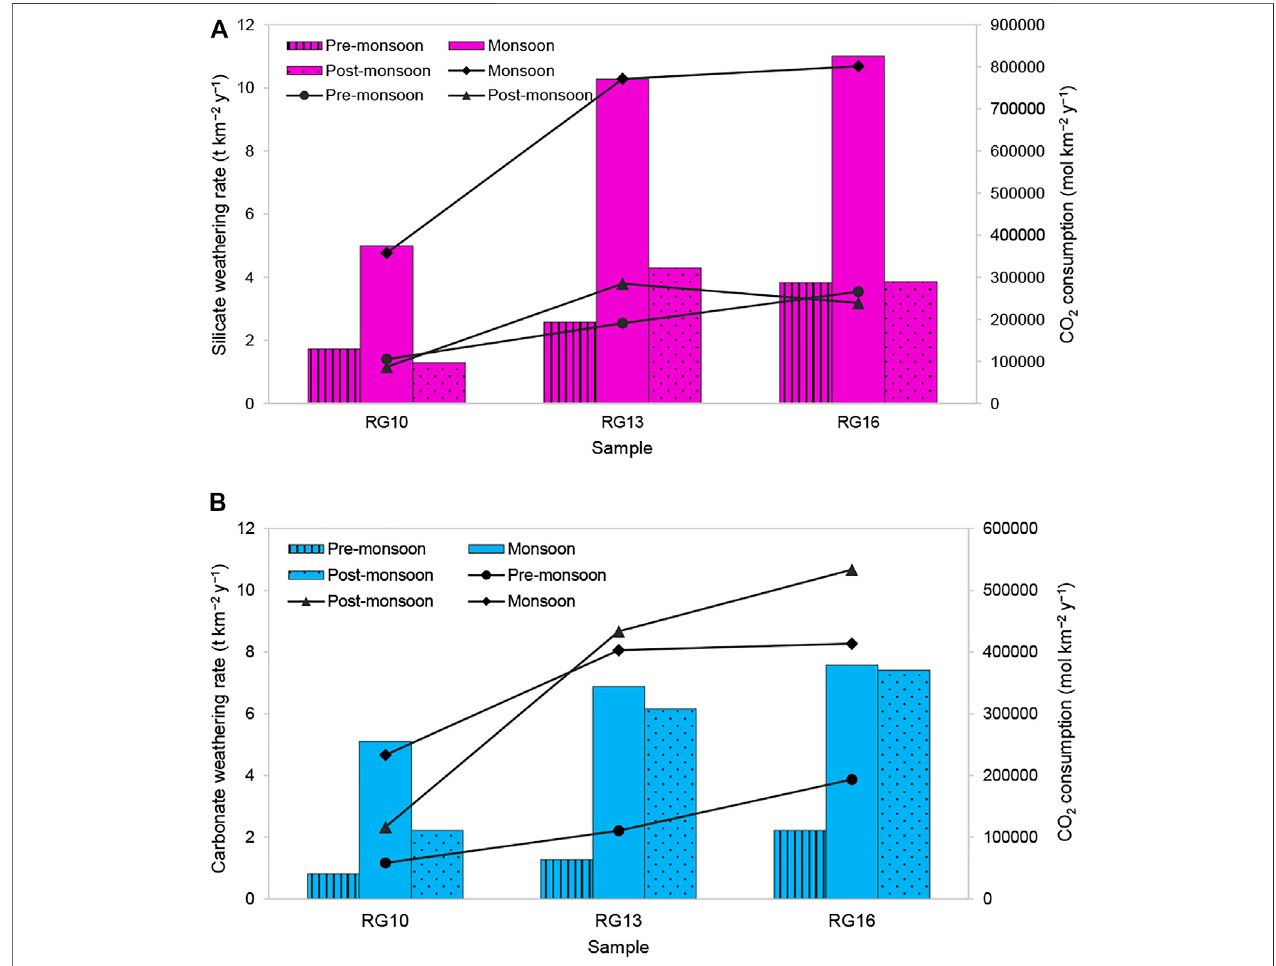
FIGURE 11 | (A) Silicate weathering rate (SWR) and resultant CO 2 consumption, (B) carbonate weathering rate, (CWR) and resultant CO 2 consumption (column indicates weathering rate and line + scatter display CO 2 consumption rate).